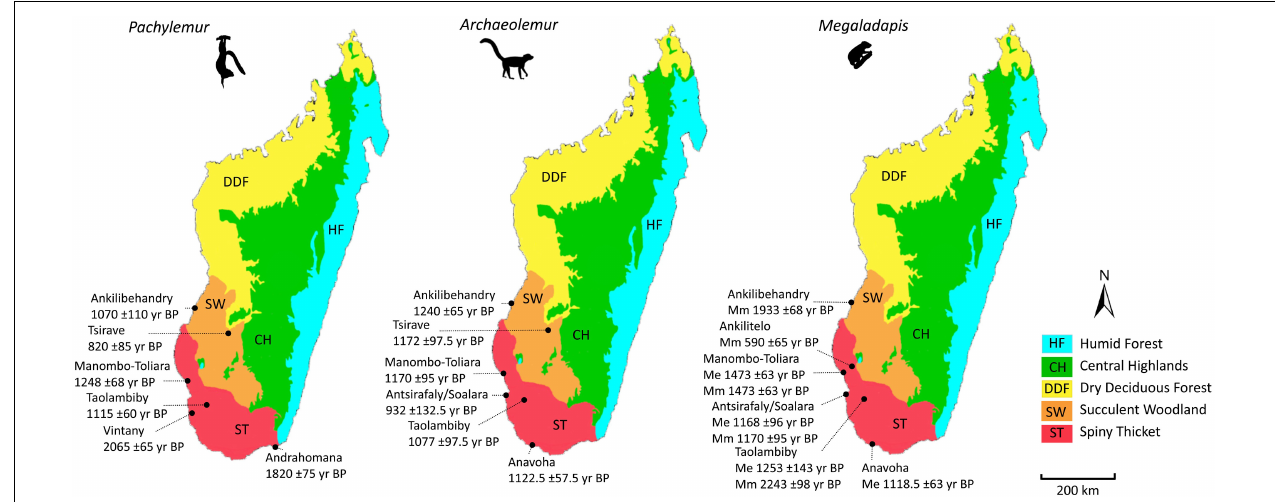
FIGURE 9 | Last occurrence dates for Pachylemur , Archaeolemur , and Megaladapis at sites in the spiny thicket and succulent woodland ecoregions of the dry southwest. For Megaladapis , Mm, M. madagascariensis , and Me, M. edwardsi . All dates are calibrated, and all major terrestrial ecoregions of Madagascar (Burgess et al., 2004) are